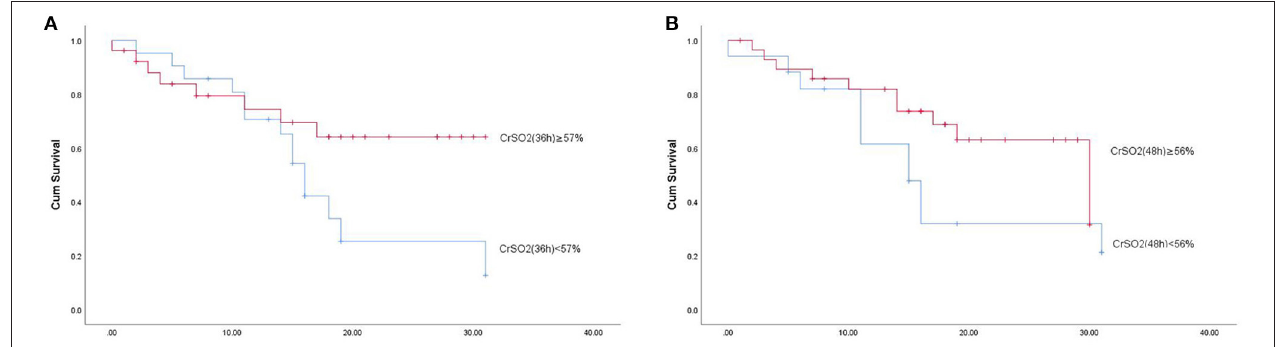
FIGURE 3 | Kaplan-Meier analysis according to CrSO2 (36h) and CrSO2 (48h) between survivors and non-survivors.